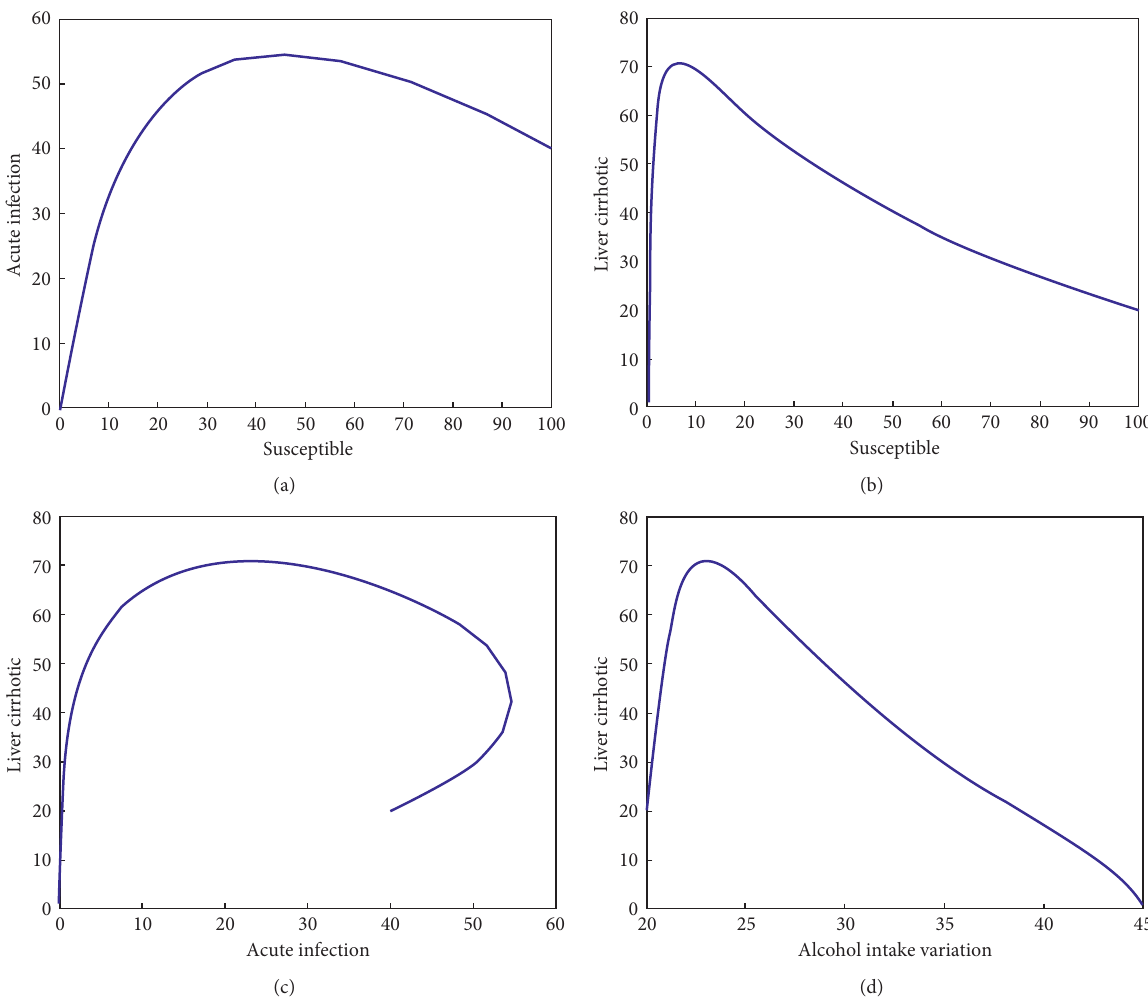
Figure 9: The phase portrait for (a) S ( t ) versus I ( t ) , (b) S ( t ) versus C ( t ) , (c) I ( t ) versus C ( t ) , and (d) A ( t ) versus C ( t )